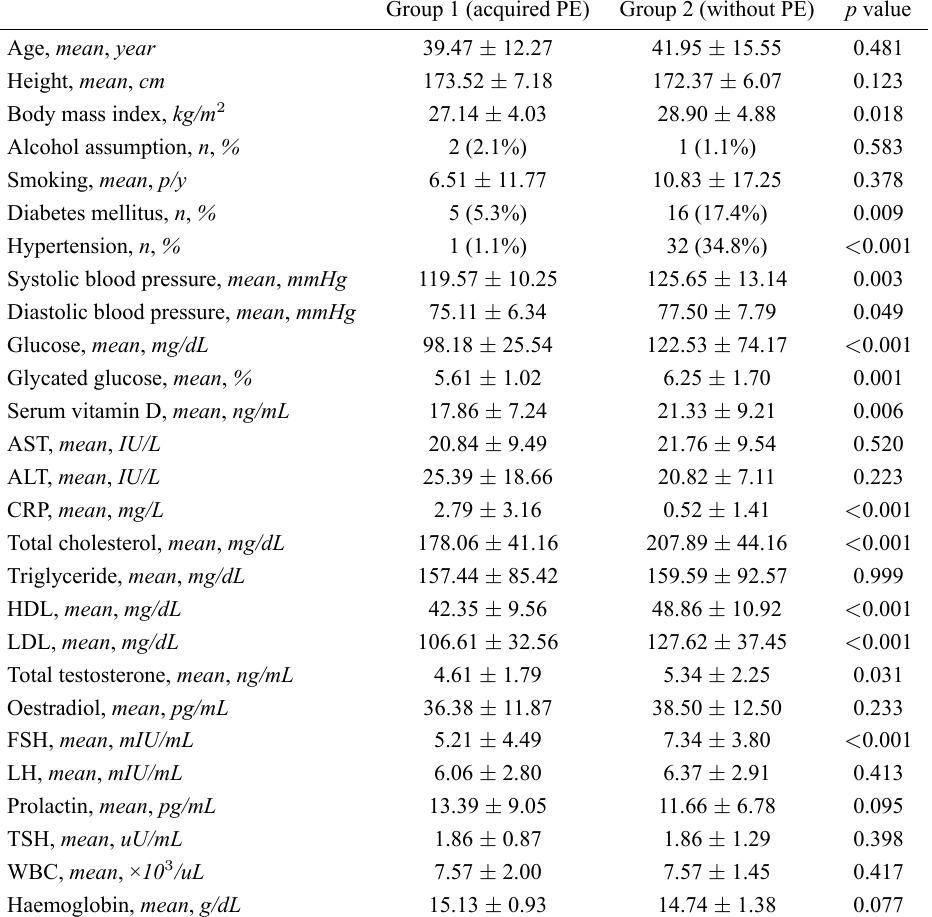
Table 1. Patients’ demographic and laboratory characteristics according to